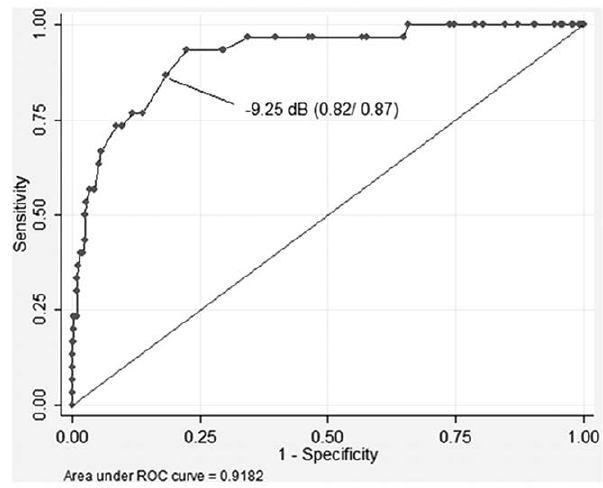
Figure 2. Receiver operating curve of SNR in comparison to PC1–PC2 . 3.4. The receiver operating curve plots the specificity versus the sensitivity of the Speech-to-noise ratio in comparison to hearing ability measured by a (PC1–PC2) . 3.4.